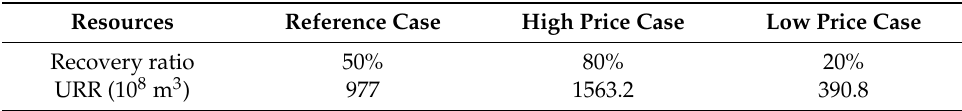
Table 3. Resources estimation under different scenarios for Fuling.